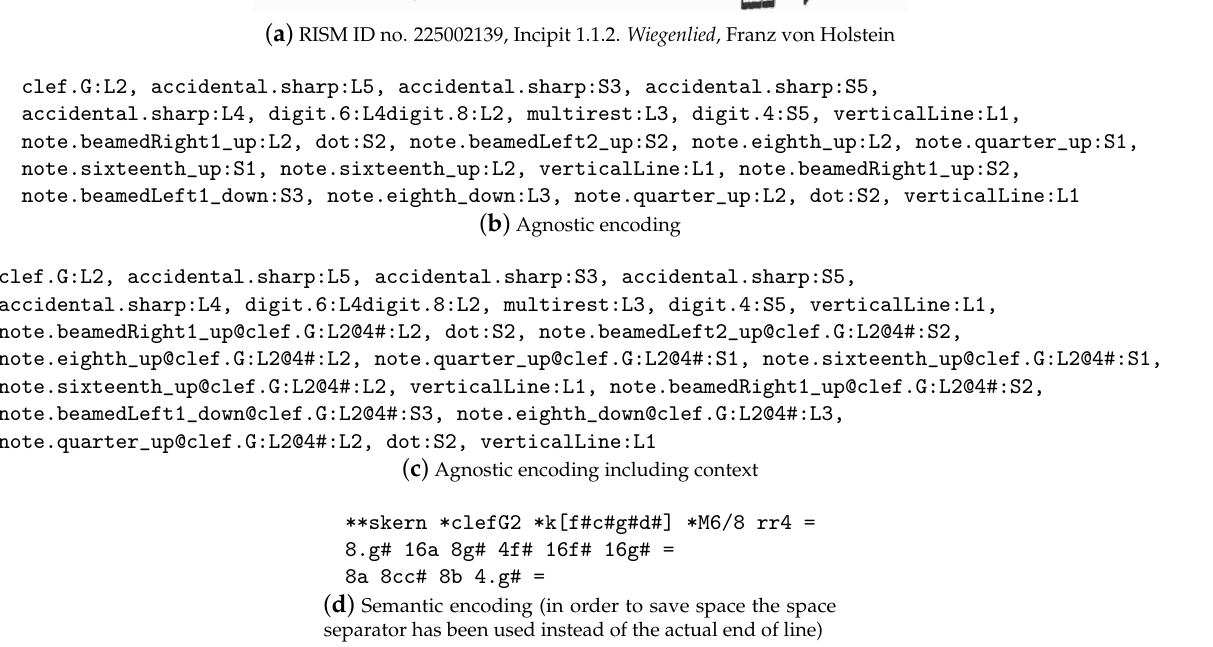
Figure A3. Sample from an incipit of the Camera-PrIMuS corpus ( a ), where we can observe the raw agnostic encoding of the shown staff ( b ), the contextual agnostic sequence ( c ) produced for the SMT model and its semantic encoding representation in **kern ∗ ( d